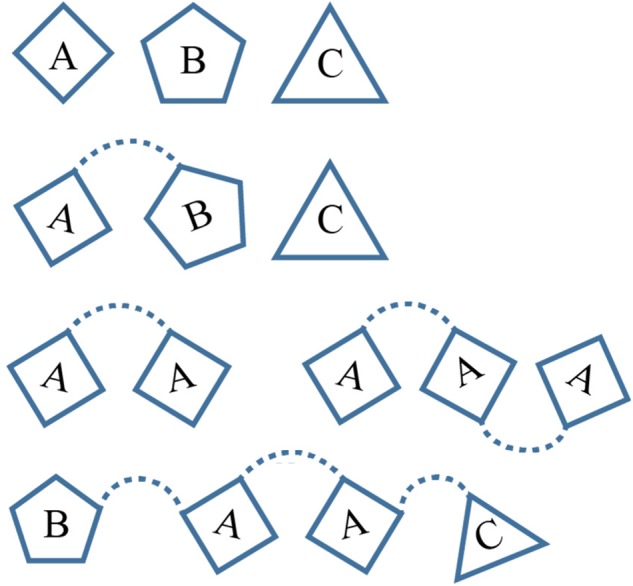
A modular description of multi-domain proteins. The top row demonstrates three separate peptides of different structural domains, while a two-domain and a single domain protein are shown below. The final two rows demonstrate the difference between a “pure domain repeat” and a “combinatorial domain repeat.”